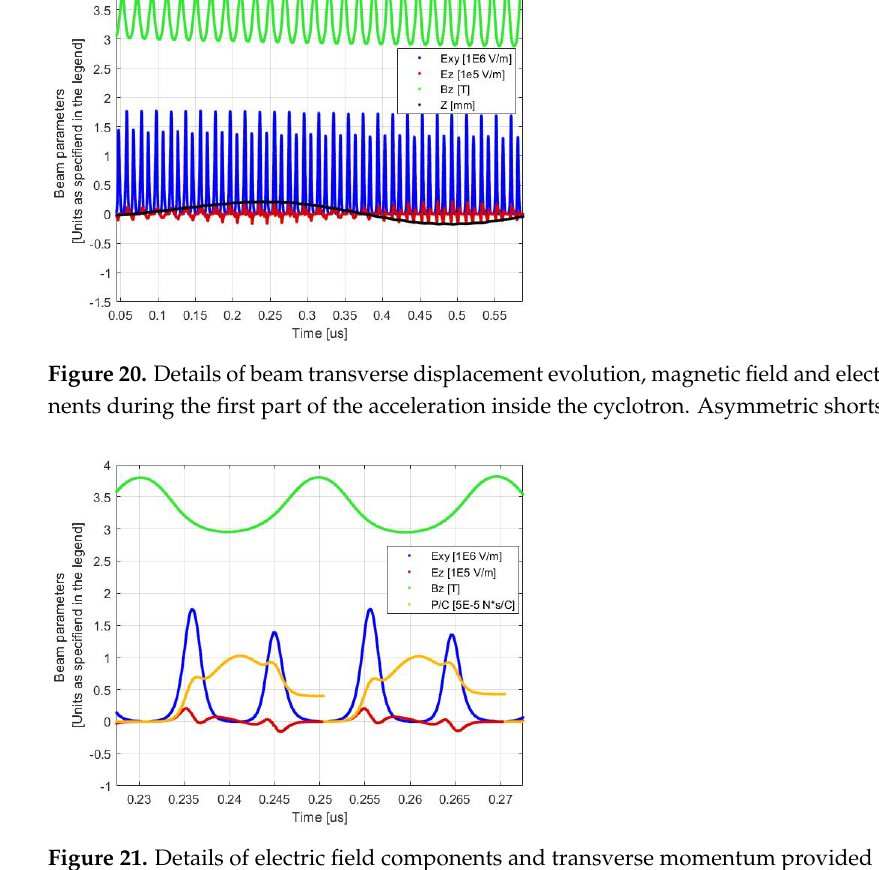
Figure 21. Details of electric field components and transverse momentum provided to the beam for two consecutive RF cavities. Asymmetric shorts